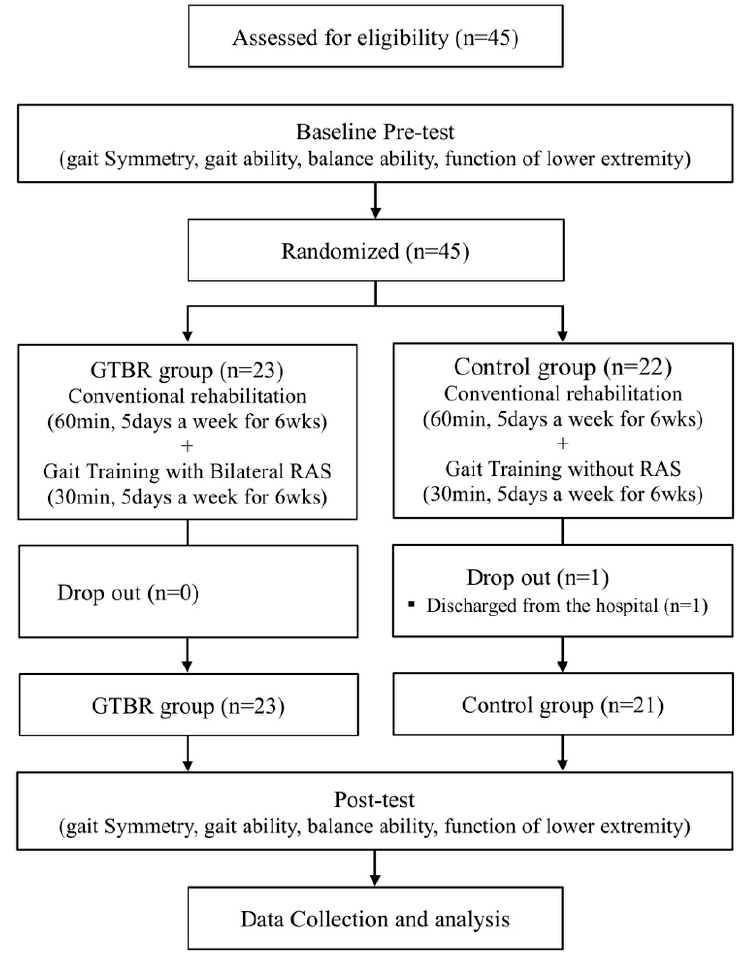
Figure 1. Flow diagram of the study.